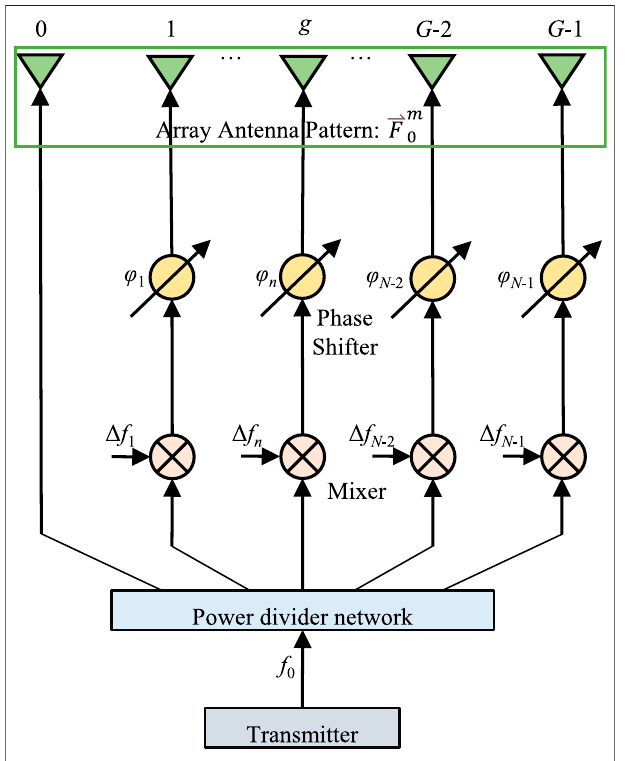
FIGURE 2 | Con fi guration of CFDA for